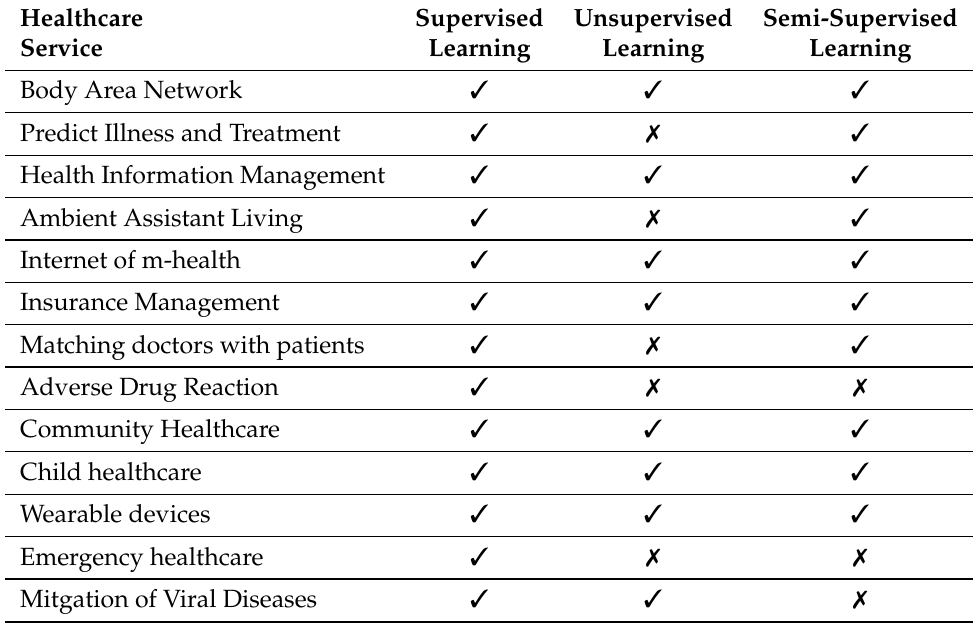
Table 2. Suitability of machine learning algorithms for healthcare service in COVID-19 mitigation. Healthcare Supervised Unsupervised Semi-Supervised Service Learning Learning Learning Body Area Network Predict Illness and